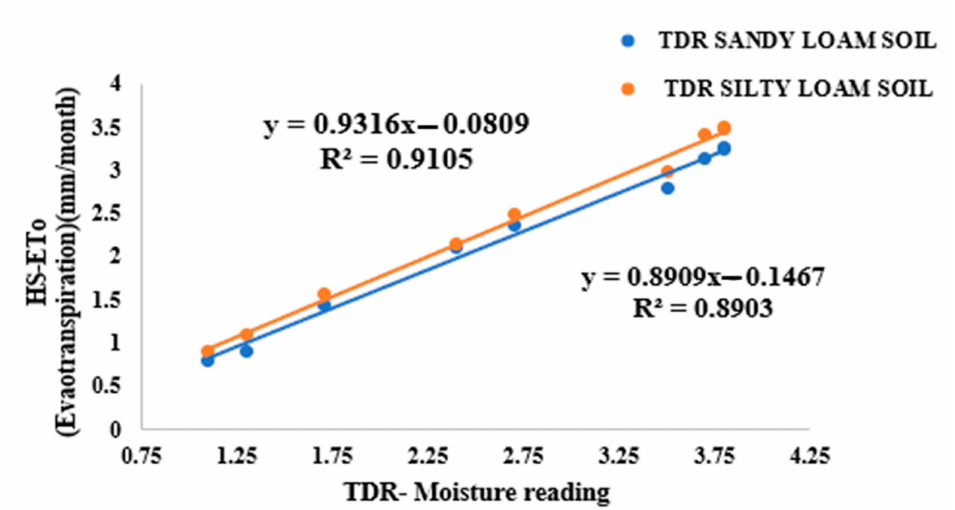
Figure 4. Correlation between HS-based evapotranspiration and TDR-based soil water readings for sandy loam and silty loam